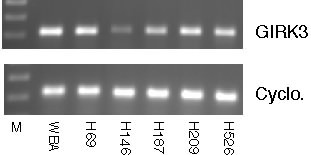
Expression of GIRK3 in SCLC cell lines. Top panel: GIRK3 expression was seen in all six SCLC cell lines, in WBA, H69, H146, H187, H209, and H526. Bottom panel: Cyclophilin, used as a positive reaction control was seen in all samples. For all gene expression experiments, negative control reactions were performed and found to be negative. The bands on the agarose gels were consistent with the expected sizes: GIRK3-317 bp; cyclophilin-216 bp; M-100 bp.